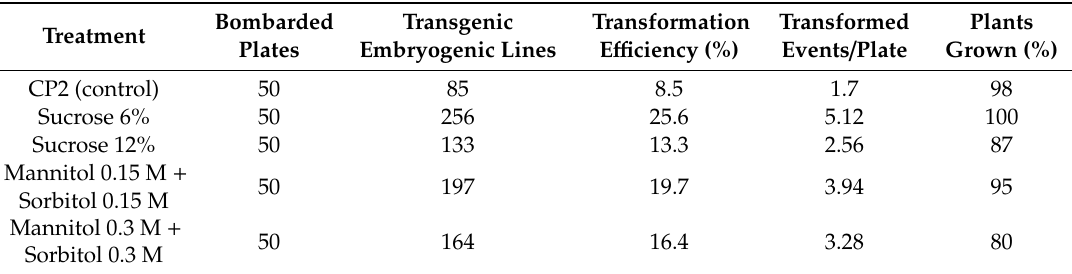
Table 1. Summary of genetic transformation events of C. arabica mediated by particle bombardment of somatic embryos with plasmid pMDC85 under di ff erent osmotic conditions. Treatment